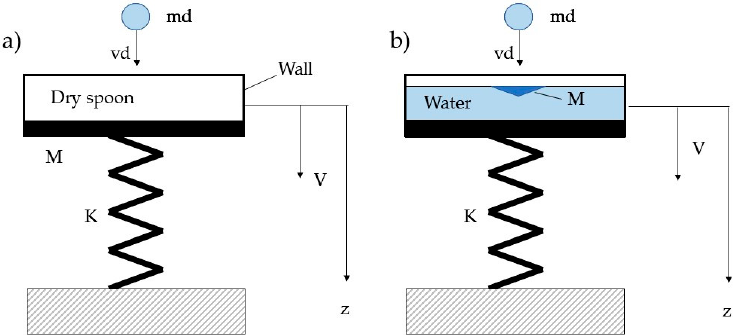
Figure 1. Raindrop impact on a dry ( a ) and wet ( b ) spoon; v d is raindrop velocity, m d raindrop mass, V spoon velocity.